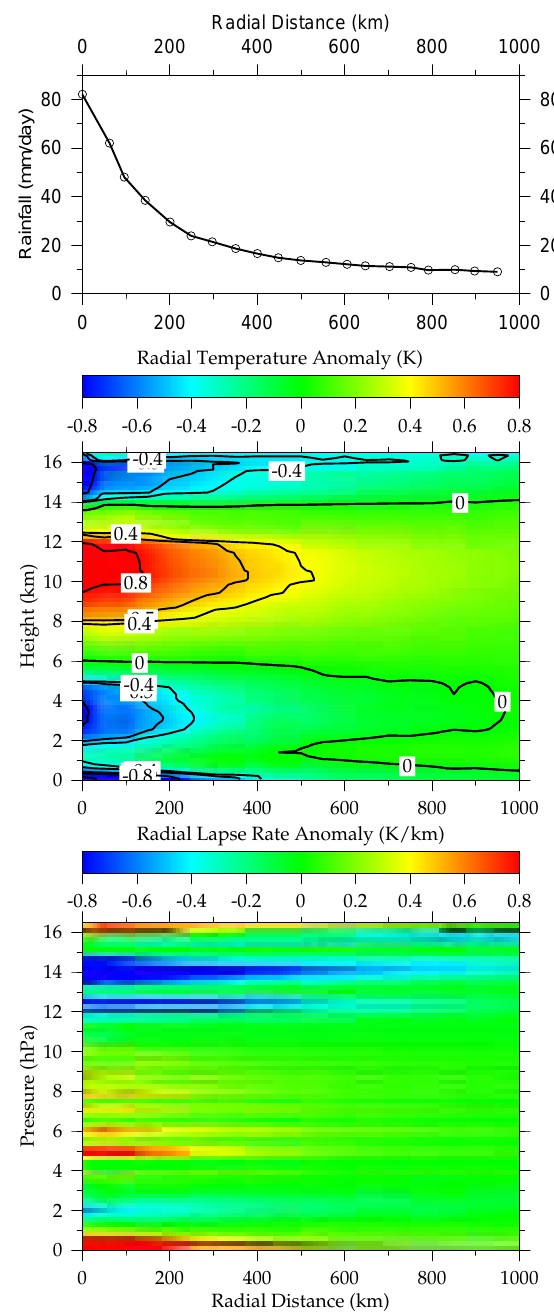
Fig. 2. (top) The mean variation in rainfall with distance from high rain events. Rain events were considered to occur at grid boxes where the rain rate in any 3 hour interval exceeded 36mmday − 1 . (middle) The temperature anomaly pattern associated with the high rain events. The horizontal axis refers to the distance between the rain event and the radiosonde location. (lower) The lapse rate anomaly associated with the temperature anomaly pattern shown in the middle panel. High rain events are associated with increased stability in the mid-troposphere.